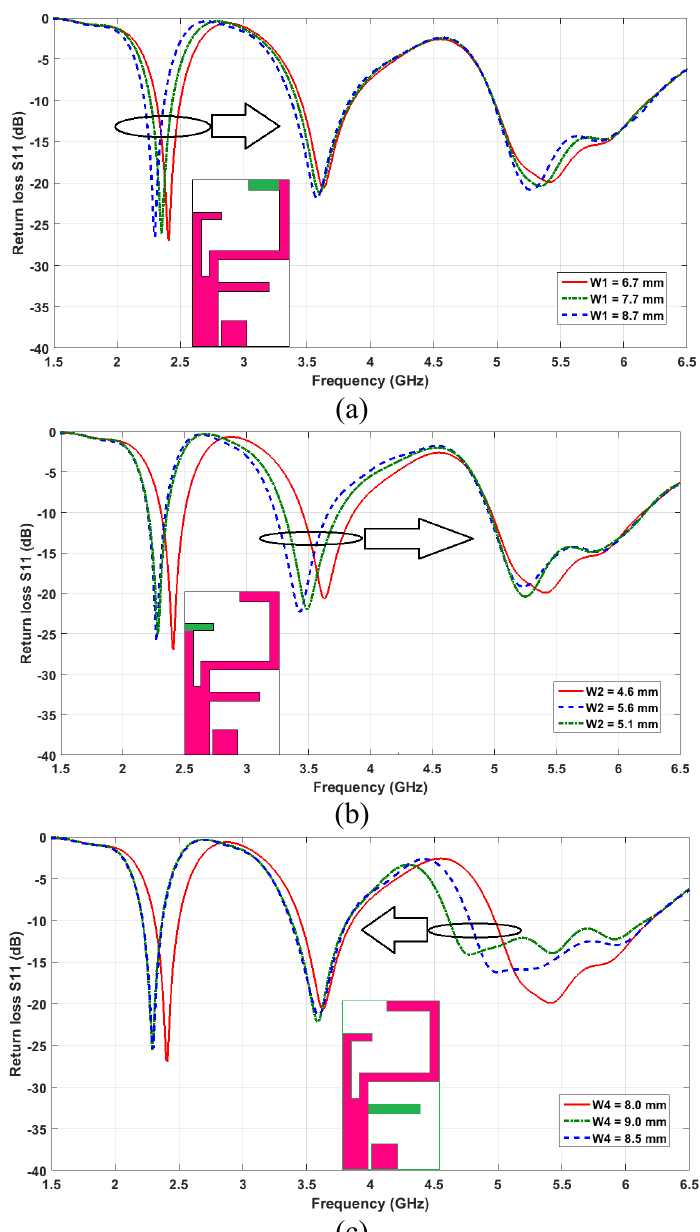
Figure 5: Effect of varying (a) W1 (b) W2 (c)